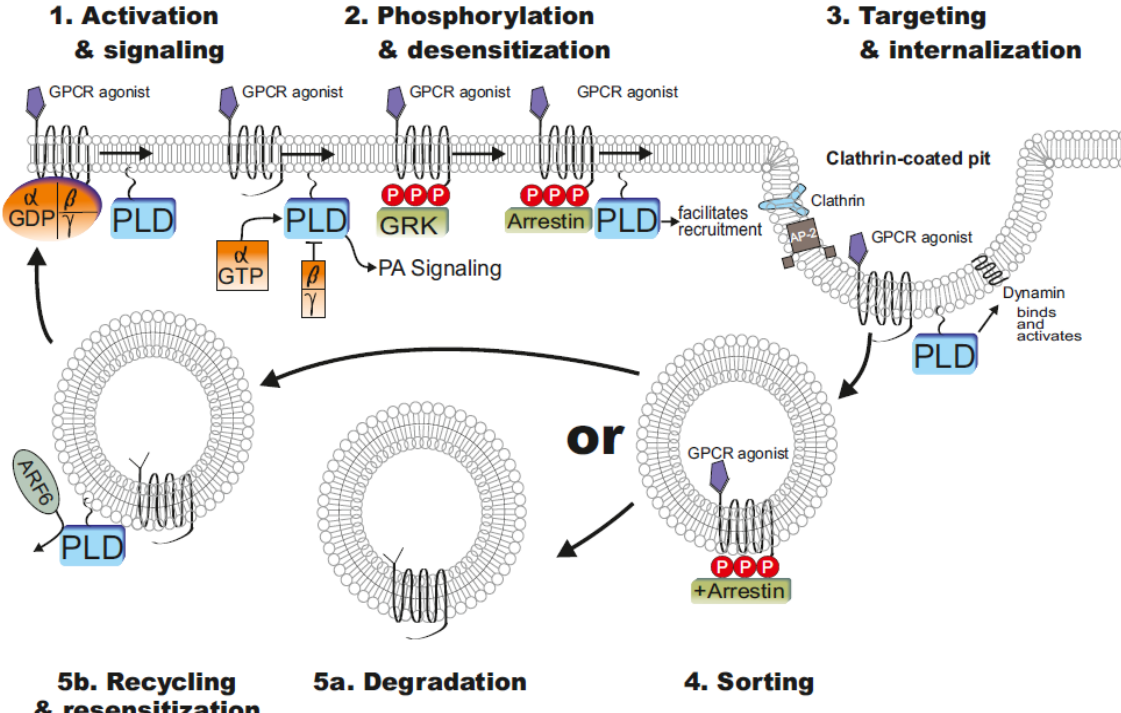
Figure 3. Regulation of G protein coupled receptor (GPCR) trafficking. Agonist binding to GPCRs leads to receptor activation, G protein coupling, and signal transduction including PLD activation. For example, whereas G α class of heterotrimers or small G proteins 12/13 such as ARF6 activates PLD, G βγ subunit of the heterotrimer can directly inhibit PLD ( step 1). G protein receptor kinases (GRKs) then phosphorylate the agonist-activated GPCR on intracellular domains, initiating arrestin recruitment. Arrestin binding to the receptor inhibits G protein coupling and terminates signaling, a process termed level facilitated recruitment of Clathrin, desensitization. PA-mediated increase of PI(4,5)P 2 dynamin and proteins of the AP-2 adapter complex ( step 2). Receptor/arrestin complexes are then targeted to clathrin-coated pits, where arrestin forms a multicomponent complex with clathrin, adapter protein-2 (AP-2), and phosphoinositides, resulting in receptor internalization. PLD directly interact with dynamin and it was suggested that PLD2 might serve as a GTPase activating protein (GAP) for dynamin ( step 3). Internalized GPCRs are sorted ( step 4) to degradation ( step 5 a ) or recycling/resensitization ( step 5 b ) compartments. ARF6 appears to be involved in the PLD mediated recycling. For details please see the paragraphs. Modified from Moore et al.